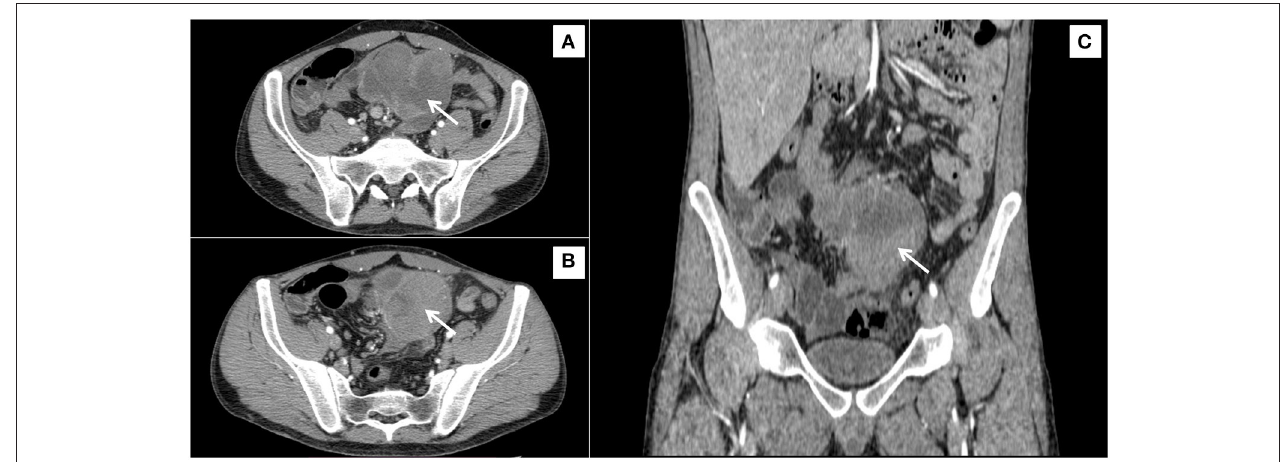
FIGURE 1 | Irregular, inhomogeneous, solid soft-tissue mass, with a diameter of 90mm, sited in the root of mesentery (arrows), in contact with the small bowel, shown from three different orientations (A–C) .